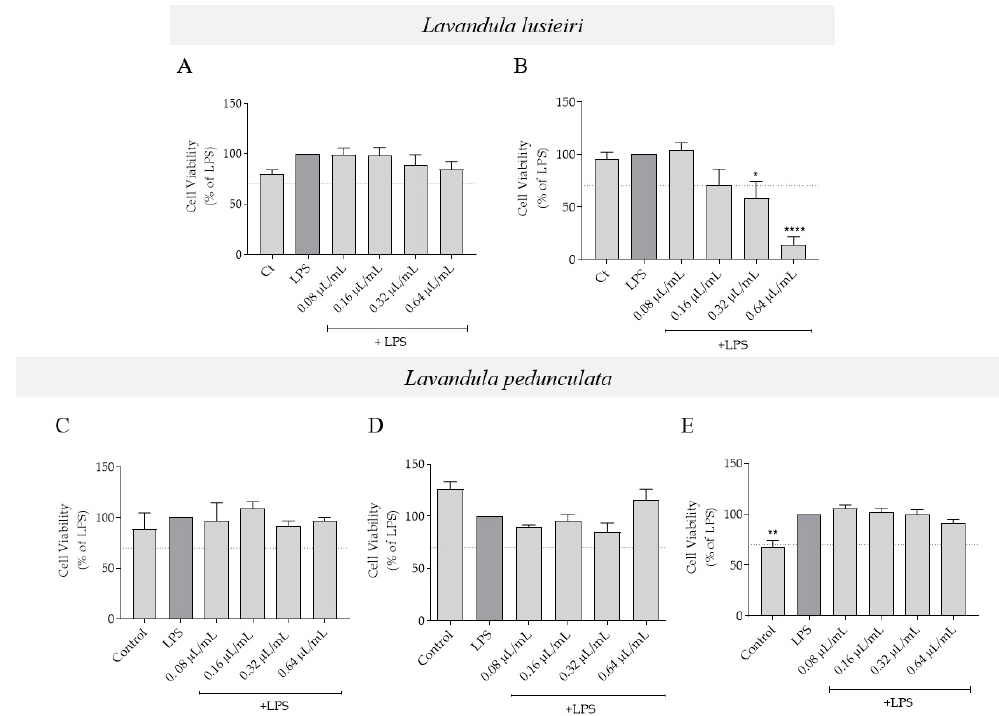
Figure 2. The effect of Lavandula spp. essential oils on cell viability. Effect of L. luisieri essential oil with ( A ) low (sample A1) or ( B ) high (sample A2) amounts of necrodane derivatives and L. pedunculata rich in ( C ) 1,8-cineole (sample B1), ( D ) fenchone (sample B2) and ( E ) camphor (sample B3) on macrophages’ viability. Cells were maintained in culture medium (control), or incubated with 1 µ g/mL LPS or with LPS in the presence of different concentrations of the oil (0.08–0.64 µ L/mL), for 24 h. Results are expressed as percentage of MTT reduction by cells treated with LPS. Each value represents the mean ± SEM of three experiments, performed in duplicate (* p < 0.05, ** p < 0.01 and **** p < 0.0001, compared to LPS). The dotted line represents the threshold (70% of maximal viability) below which cytotoxicity is recognized, in agreement with standard ISO 10993-5